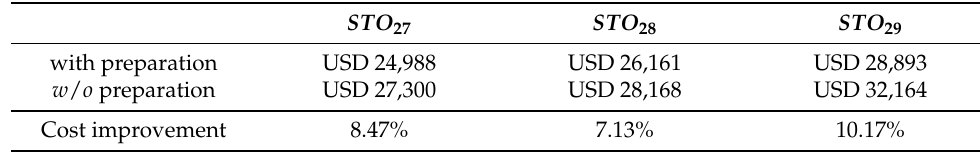
Table 5. Total MG operation costs according to STO l in Case